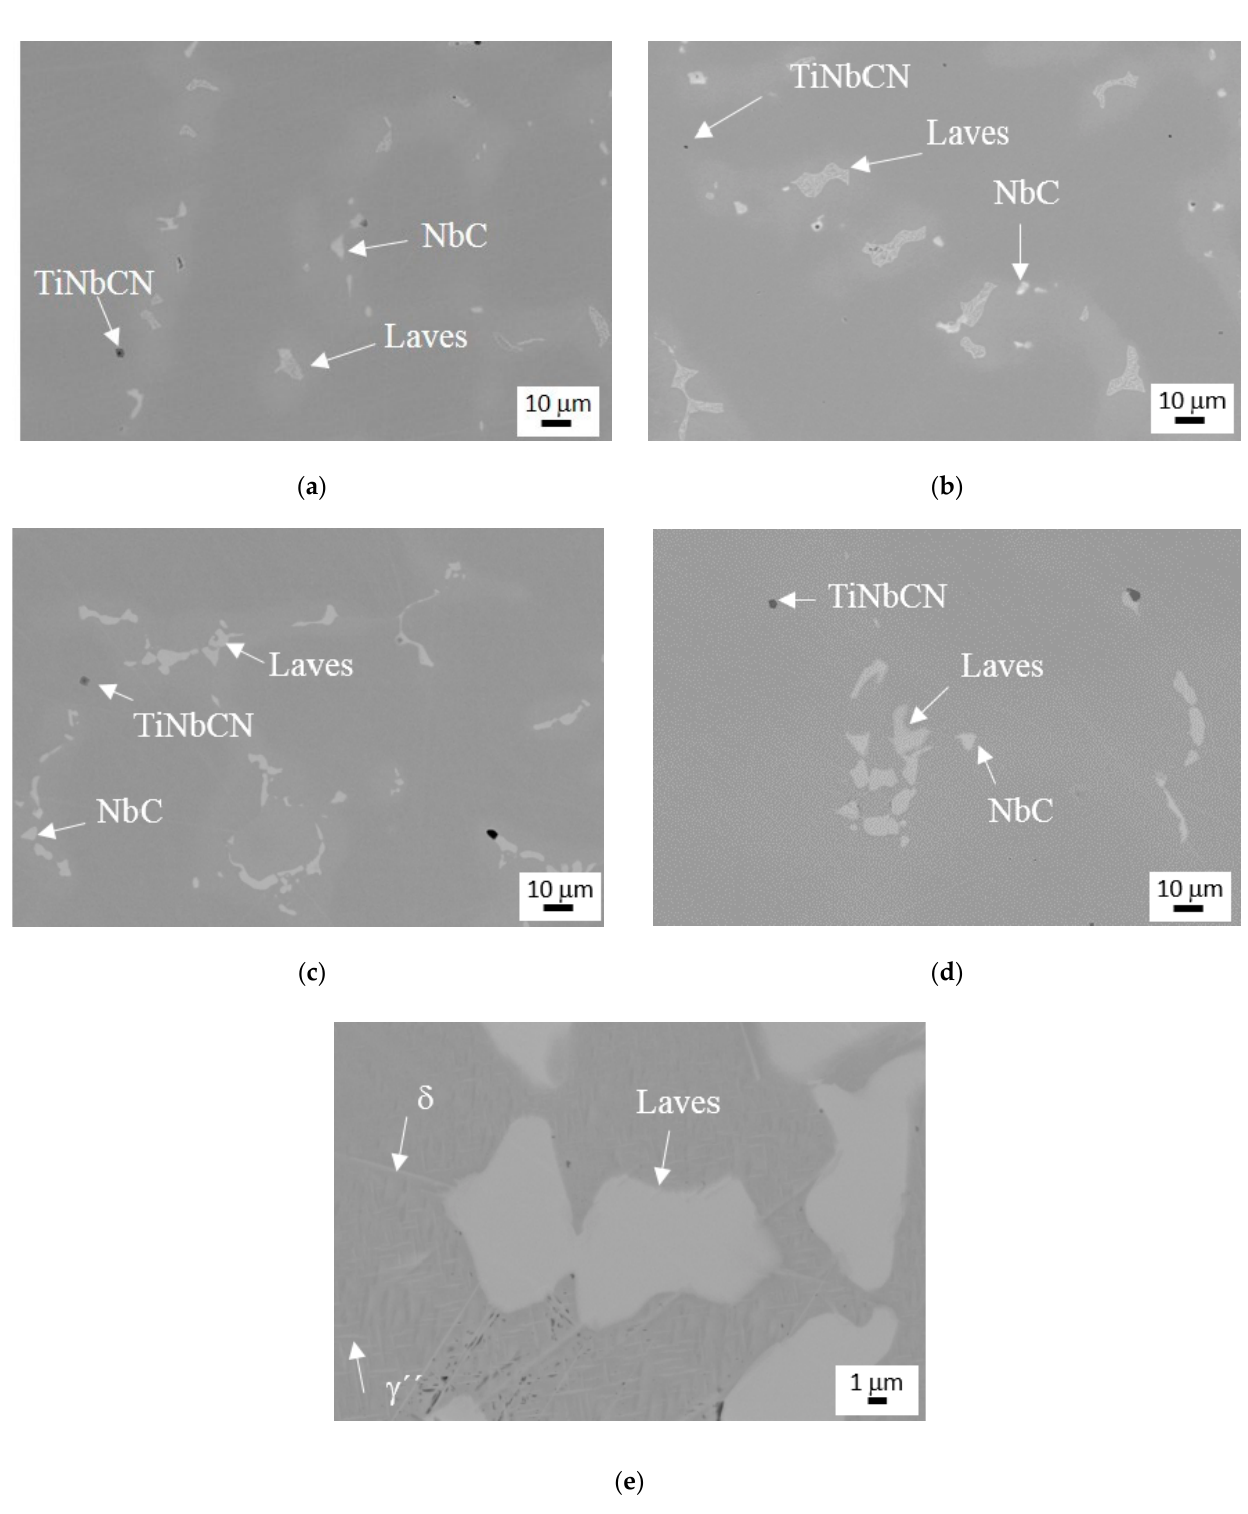
Figure 4. Secondary phases present in the microstructure of different moulds in the as-cast state: ( a ) O, ( b ) E, ( c ) P, and ( d ) NP; ( e ) NP: magnification of ( d ) showing the presence of Laves, δ phase, and γ ’’ in the interdendritic region.